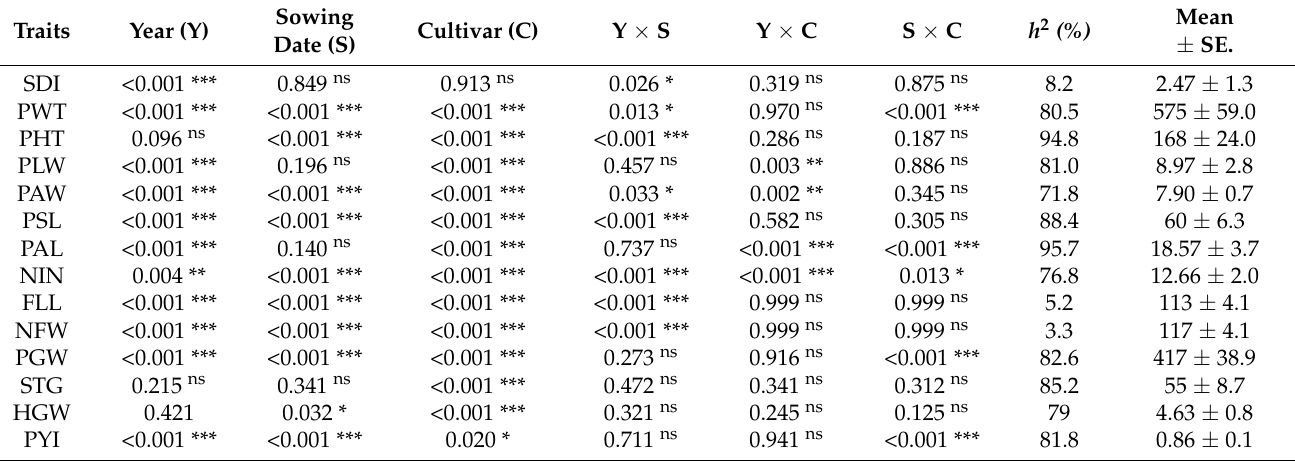
Table 2. p -values from ANOVA for assessed traits of 55 Chadian dry-season sorghum as affected by year (Y), sowing date (S), and the cultivar (C), with mean values plus/minus standard error